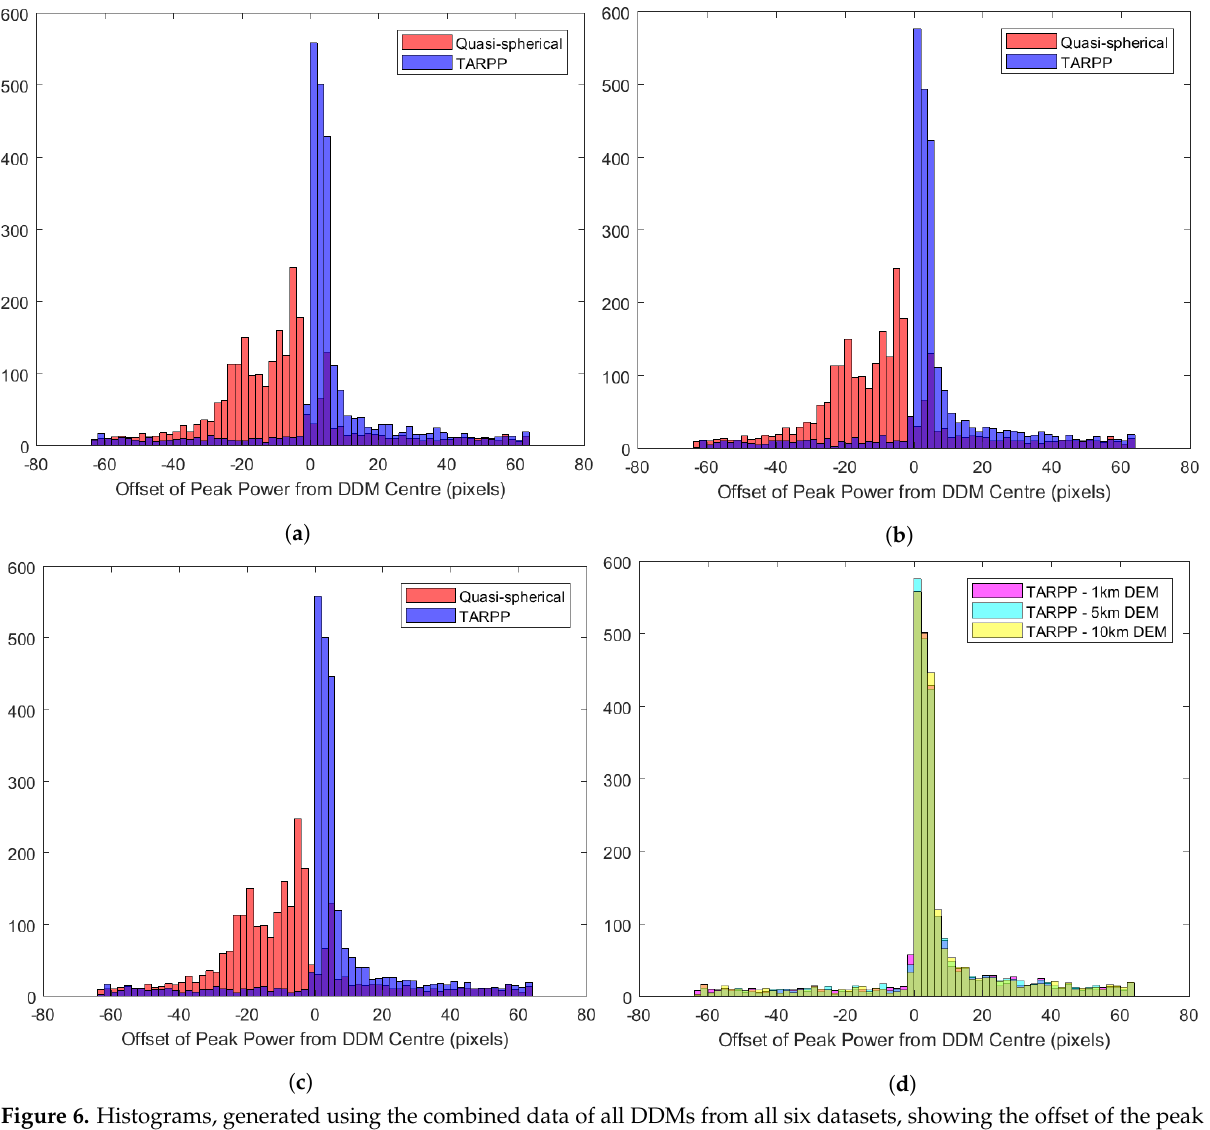
Figure 6. Histograms, generated using the combined data of all DDMs from all six datasets, showing the offset of the peak power pixel from the centre of the DDM. The three DEM resolutions are shown and compared with the quasi-spherical model in ( a – d ) shows the three DEM resolutions directly compared to each other. All three resolutions have a similar performance and thus the histograms nearly overlay each other, and so appear green. ( a ) 1 km DEM; ( b ) 5 km DEM; ( c ) 10 km DEM; ( d ) DEM